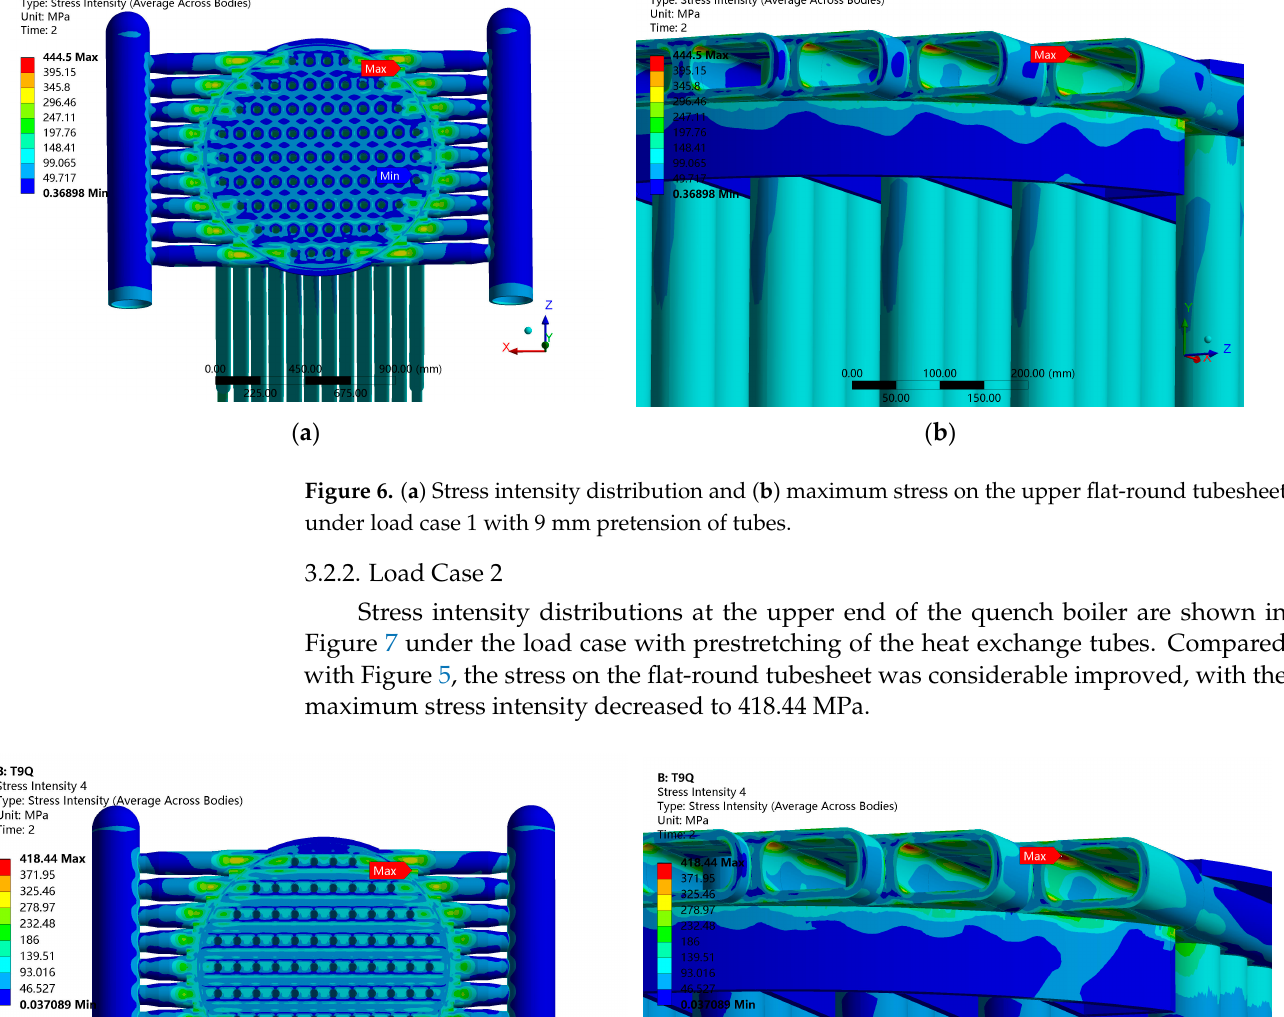
( b ) Figure 5. ( a ) Stress intensity distribution and ( b ) maximum stress on the upper flat-round tubesheet under load case 2 without prestretching of the tubes.